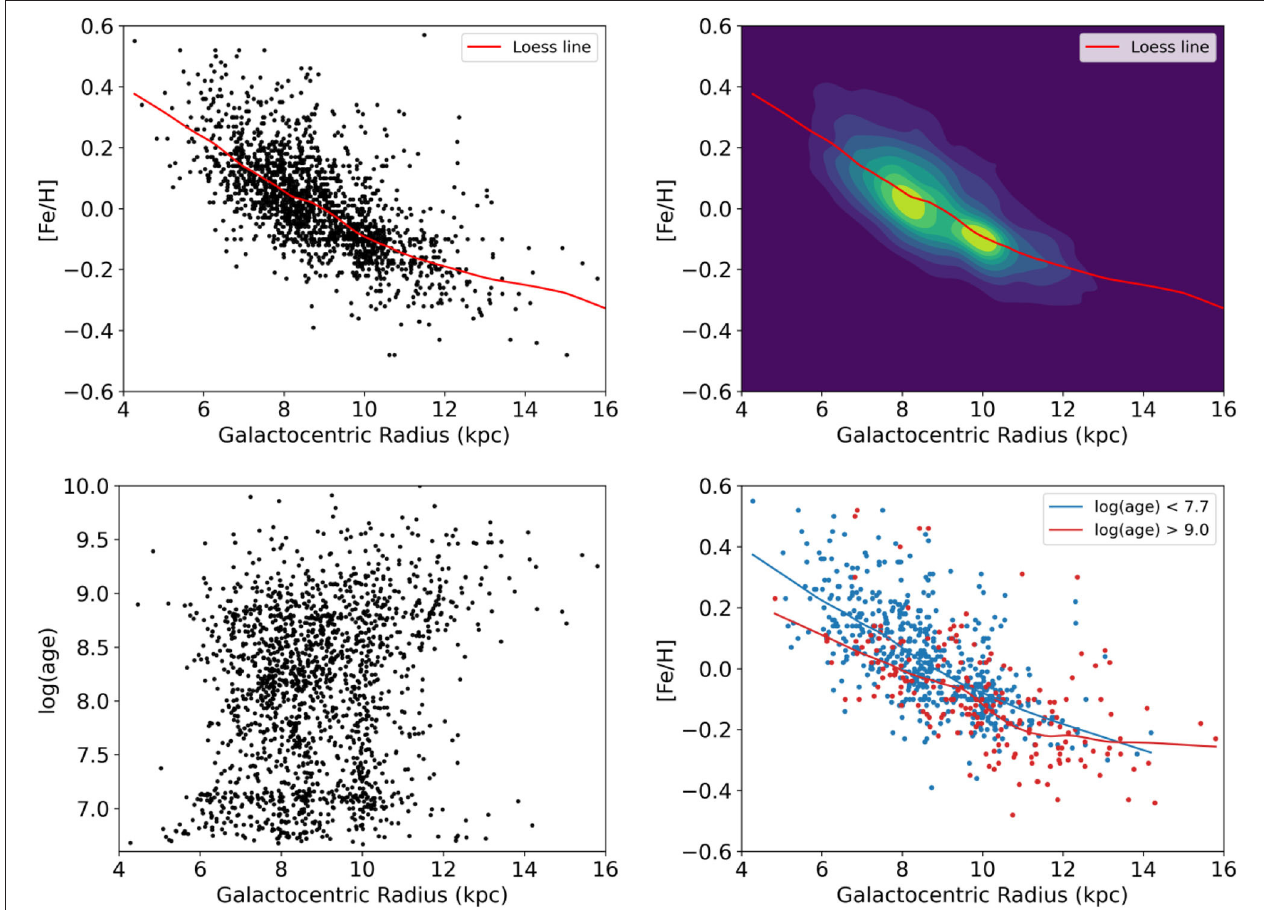
FIGURE 9 | Metallicity, equal to iron abundance log [Fe/H] normalized to the Solar value as a function of Galactic radius. In the upper left panel we show all individual points with a non-parametric regression LOESS line over-plotted. In the upper right panel a kernel density estimate in ([Fe/H], radius) space is shown. A gap at 9kpc can be seen, as well as a slight flattening of the gradient beyond 10kpc. In the lower left panel the logarithm of the age of the clusters is presented as a function of the Galactic radius, showing a prevalence of old clusters in the region with radius larger than 11kpc. In the lower right panel, the [Fe/H] distribution of the old and young population of clusters is shown with their respective non-parametric regression LOESS line